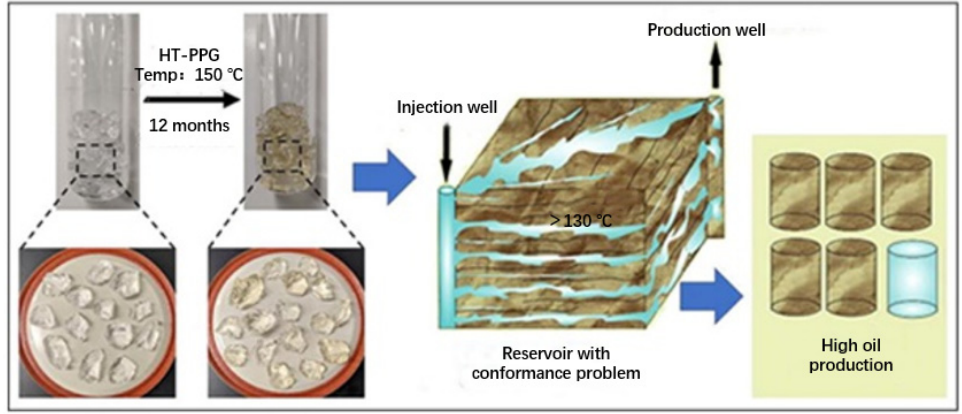
Figure 6. Simulation of the high-temperature aging test and formation application of HT-PPGs. (Reprinted/adapted with permission from Ref. [45], 2021, Salunkhe et al.).